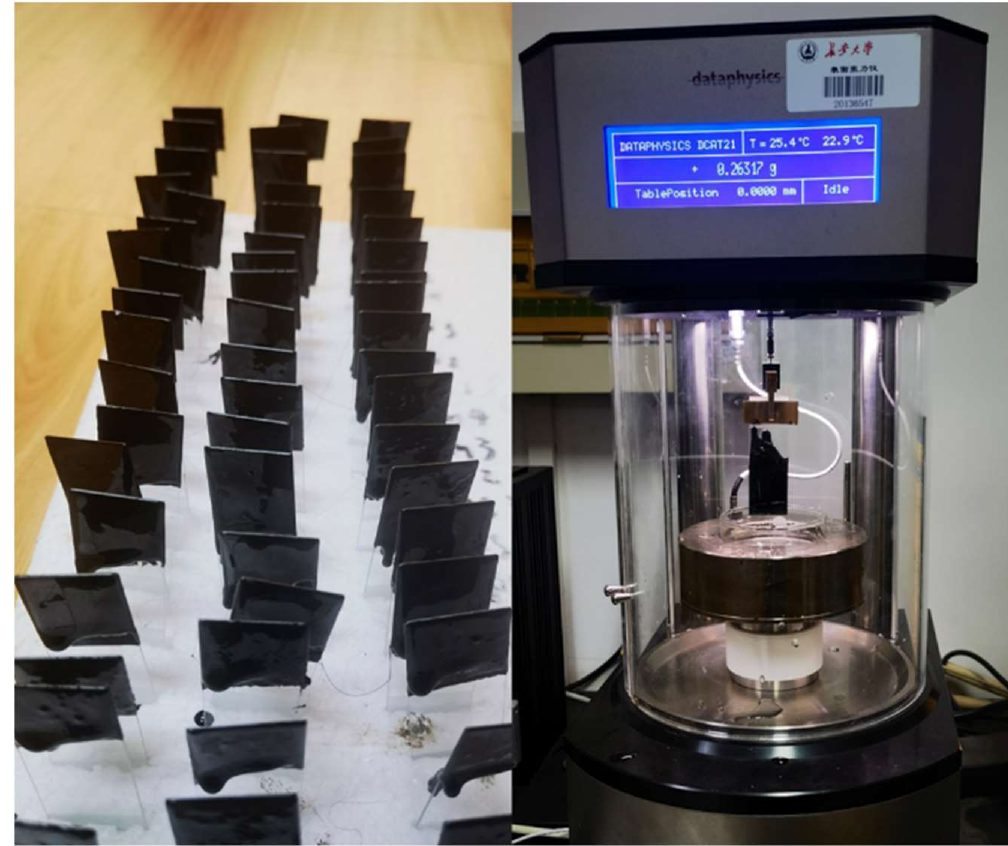
Figure 2. Dynamic surface tensiometer.